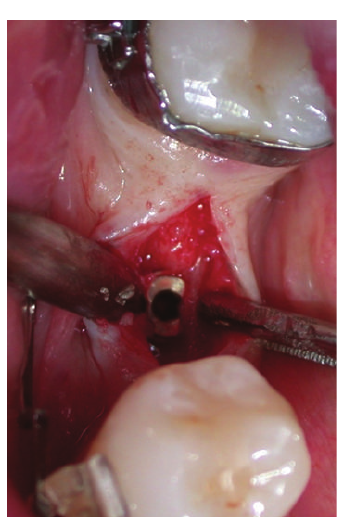
Figure 14: Healing abutment